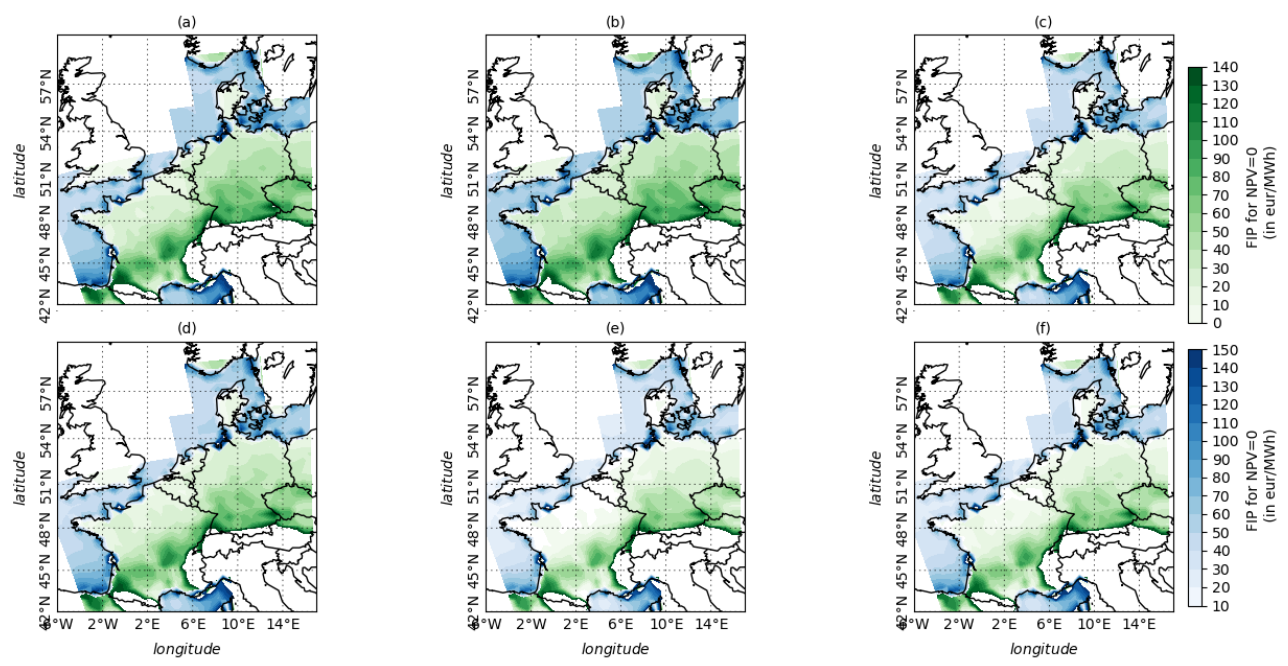
Figure 10. Premium level ensuring wind farm profitability under the 6 considered scenarios. Scenario 1: No demand trends and low wind penetration ( a ); Scenario 2: No demand trends and high wind penetration ( b ); Scenario 3: Medium demand trends and low wind penetration ( c ); Scenario 4: Medium demand trends and high wind penetration ( d ); Scenario 5: High demand trends and low